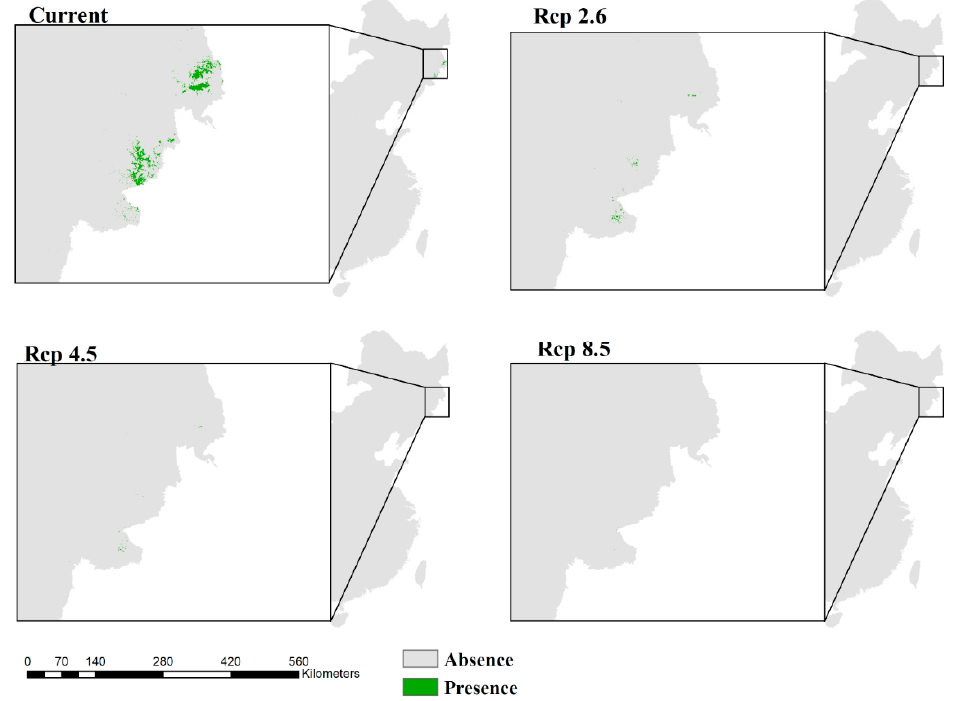
Figure 2. Binary distribution maps for T. cuspidata under current and future (RCP 2.6, RCP 4.5, and RCP 8.5 in 2070) environmental conditions, simulated by SDMs with the constraints of topography.